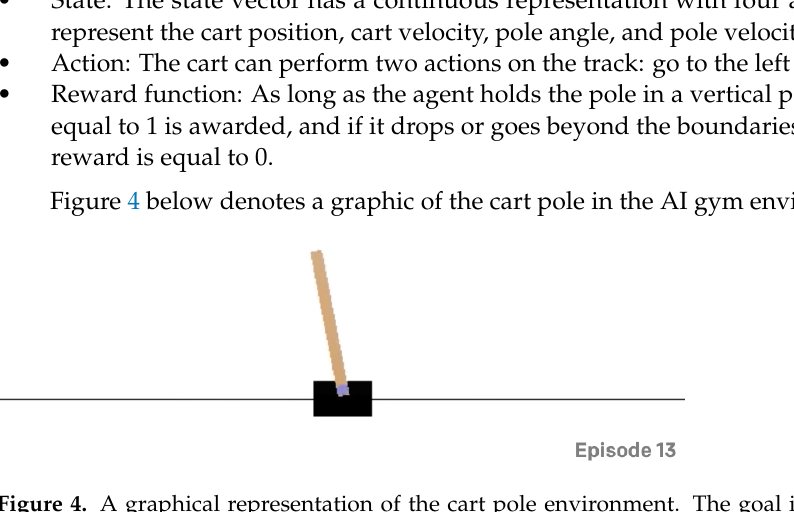
Figure 4. A graphical representation of the cart pole environment. The goal is to keep the pole balanced while applying forces to the carriage. The terminal condition is that the pole deviates more than 15 degrees from the vertical or the wagon moves 2.4 units from the